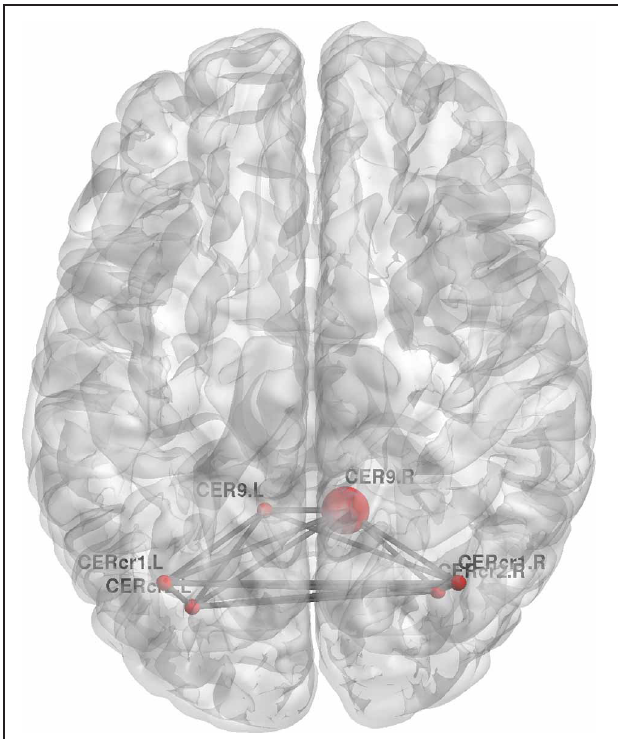
FIGURE 10 | Change regional local efficiency following the visuo-motor performance task. The format is the same as in Figure 7 ; the figure here represents significant decreases in local efficiency between the two rest conditions are highlighted in blue.